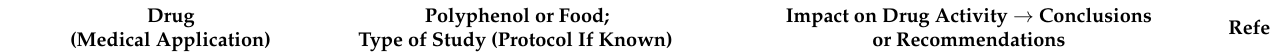
Table 2. Examples of polyphenol-drug